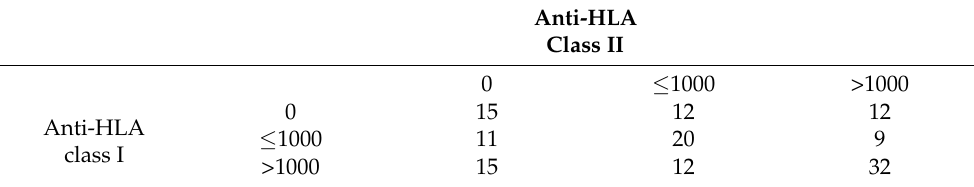
Table 4. The comparison of class I and class II anti-HLA levels in individual patient subgroups.